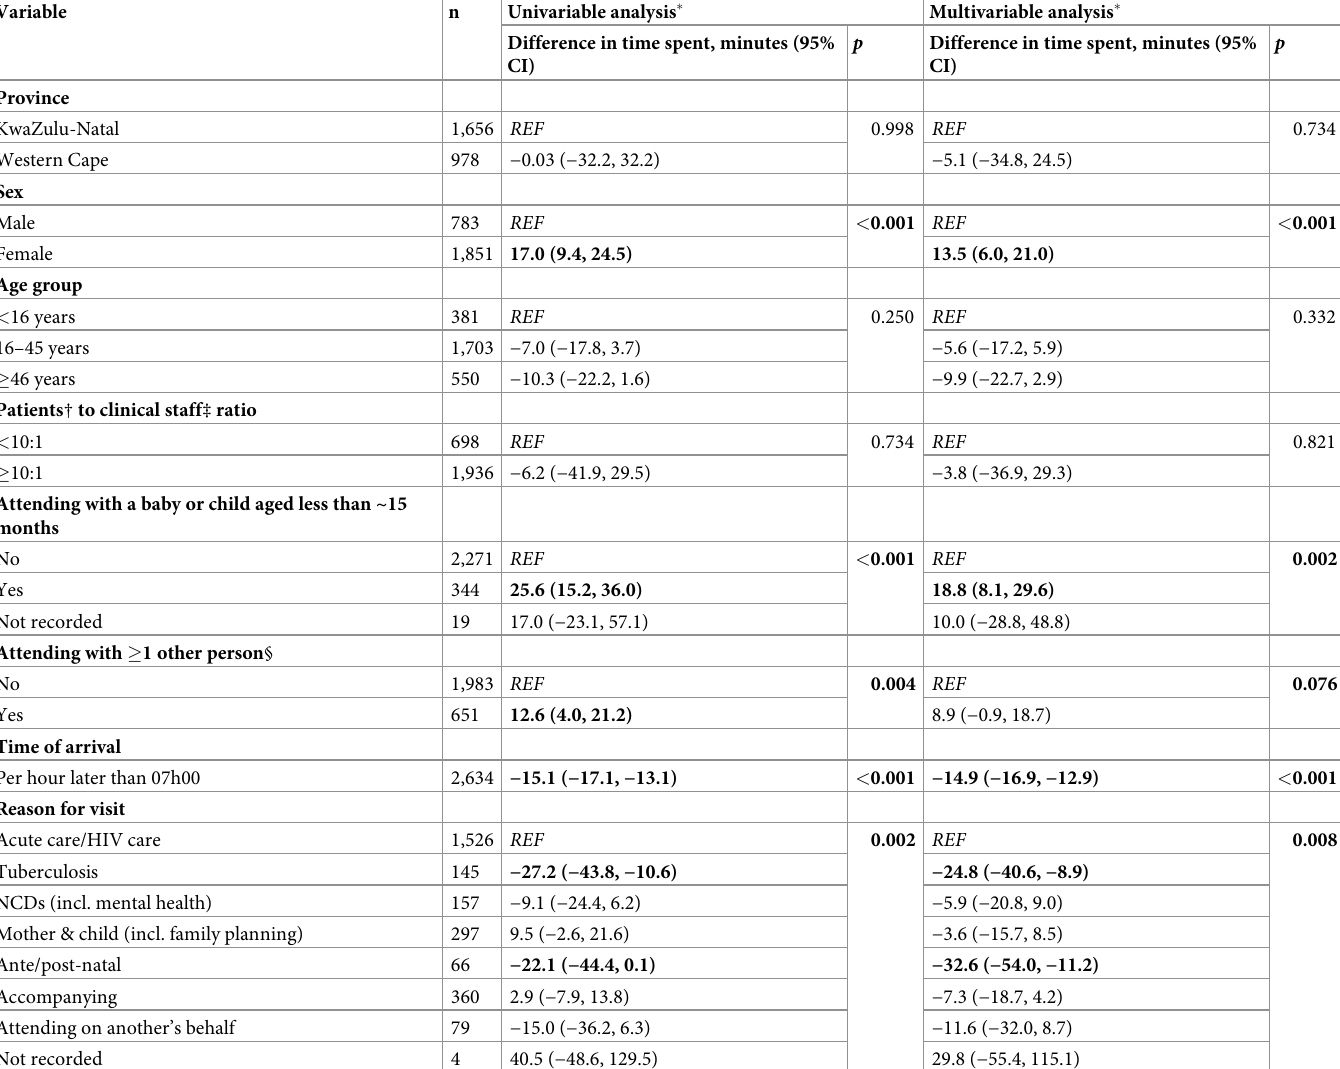
Table 2. Results of univariable and multivariable mixed-effects linear regression using imputed data, showing effects of different factors on total time spent in clinic (n = 2,634; 11 exercises in 10